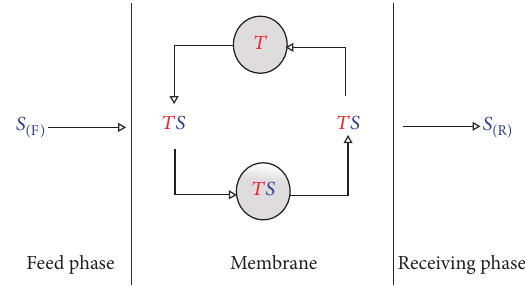
Figure 1: Facilitated transport and extraction mechanism through a